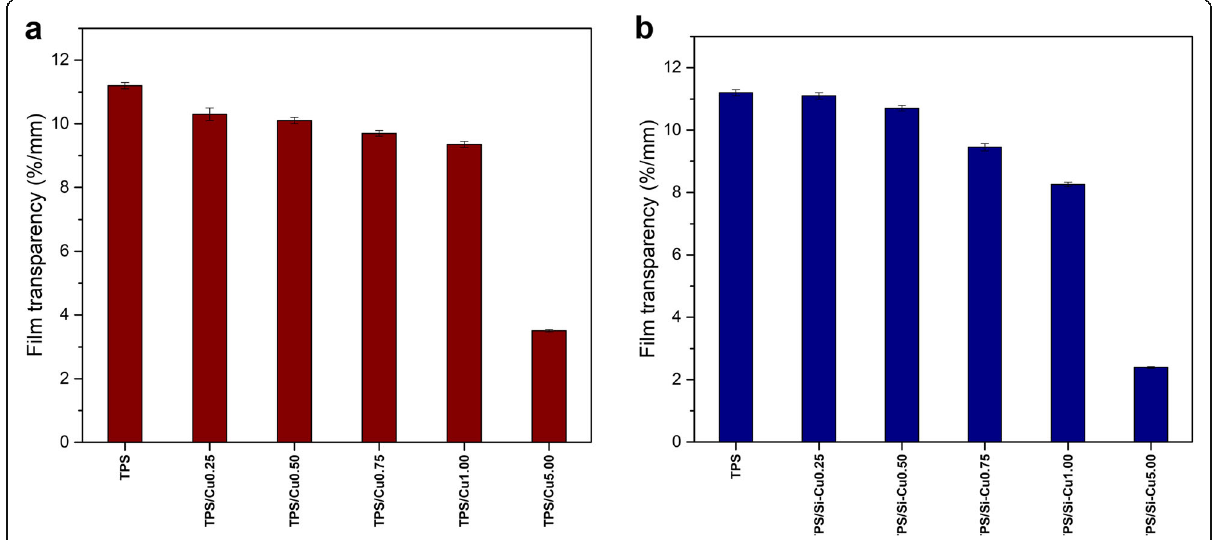
Fig. 4 Transparency of TPS composite films containing a ) Cu particles and b ) Si-Cu